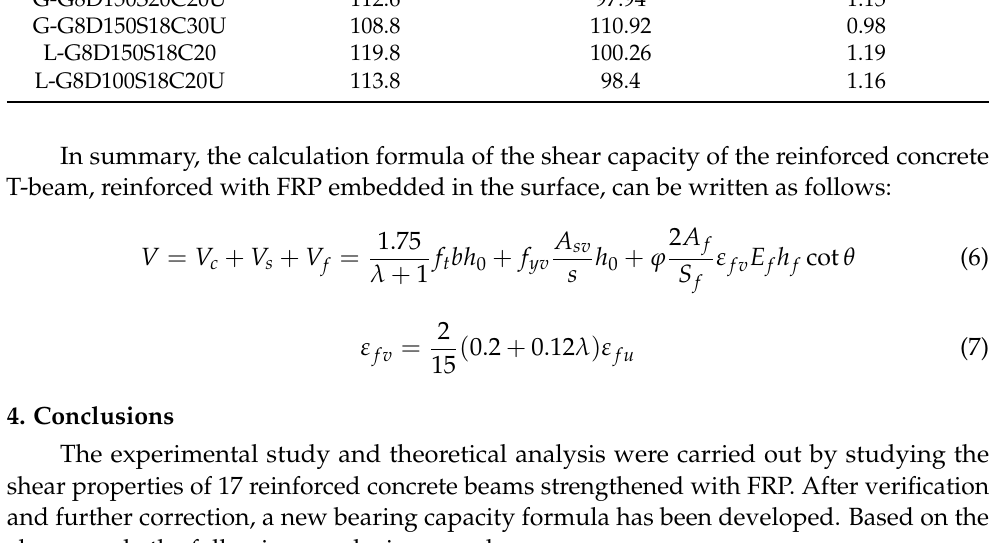
Figure 10. V f Fitting curve between experimental value and theoretical value V f .